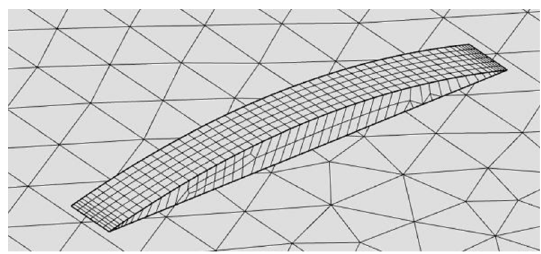
Figure 17. Mesh detail over the deposited metal; quad faces of 0.045 mm average edge size.